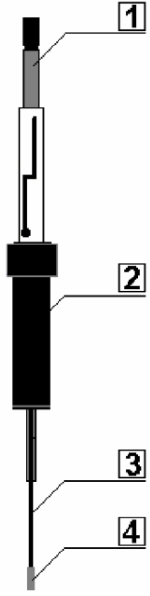
Figure 8. The structure of a stationary phase microextraction device (SPME). 1—piston; 2—cylinder; 3—needle; 4—extraction